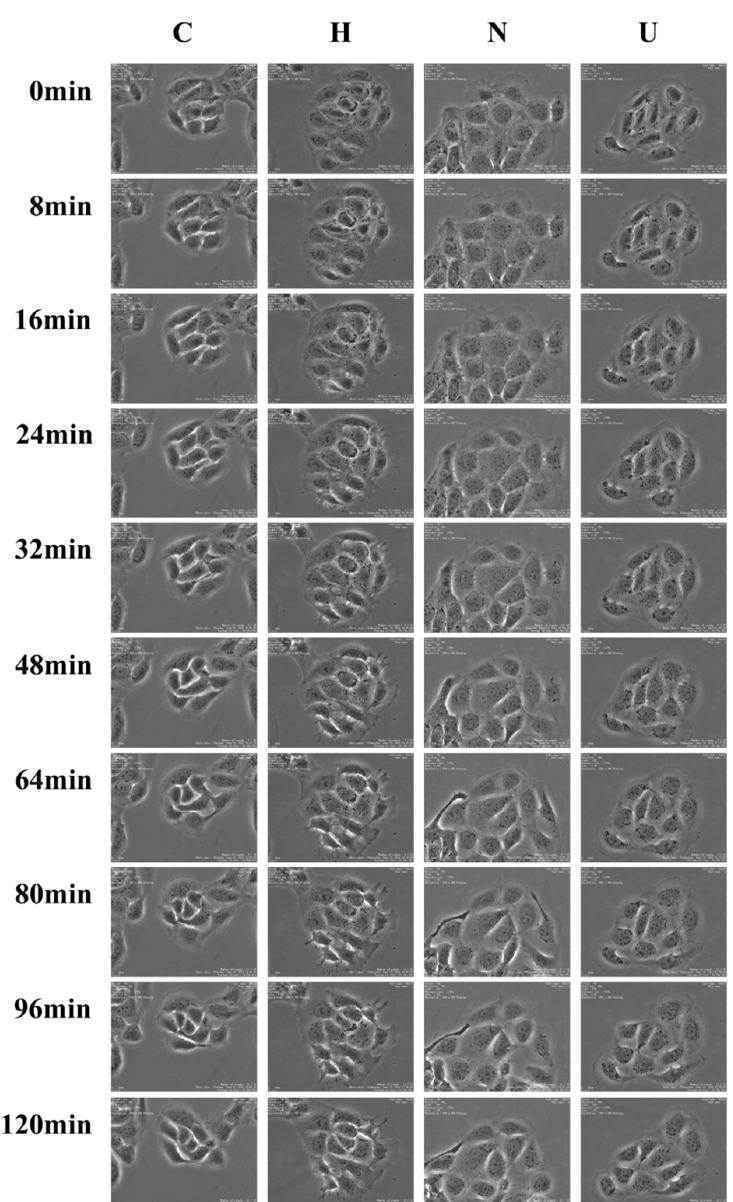
Figure 6. Representative photographs (objective 40×) from time-lapse imaging analysis of UB-NLC protecting against oxidative damage. C: Normal culture group; H: Only oxidative damage group; N: UB-NLC (0.025 mg/mL)-treated group; U: Free UB-treated group.